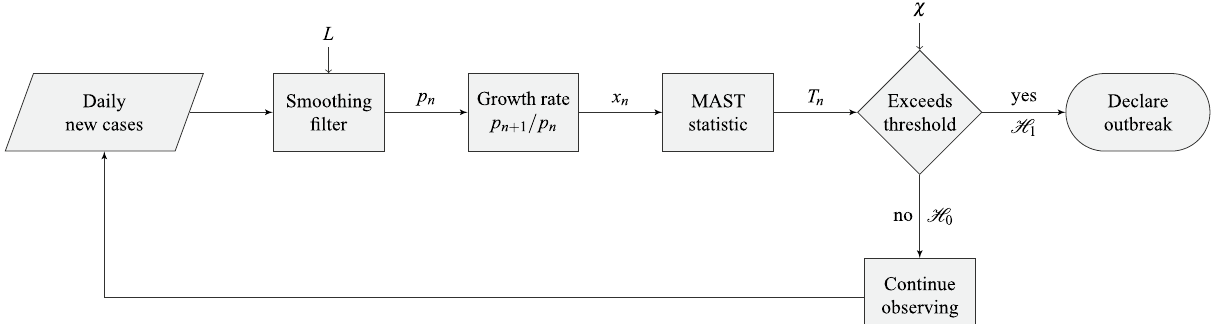
Figure 5. Flowchart of the proposed MAST procedure. Input data are the daily infected. These noisy data are filtered to mitigate imperfections in data collection, randomness, and delays. Filtered daily positive p n are used to compute the growth rate x n , which is used to compute the MAST statistic T n . The statistic is then compared with the threshold χ ; if it is larger than the threshold, the outbreak is declared. Otherwise, the procedure continues to collect and process the